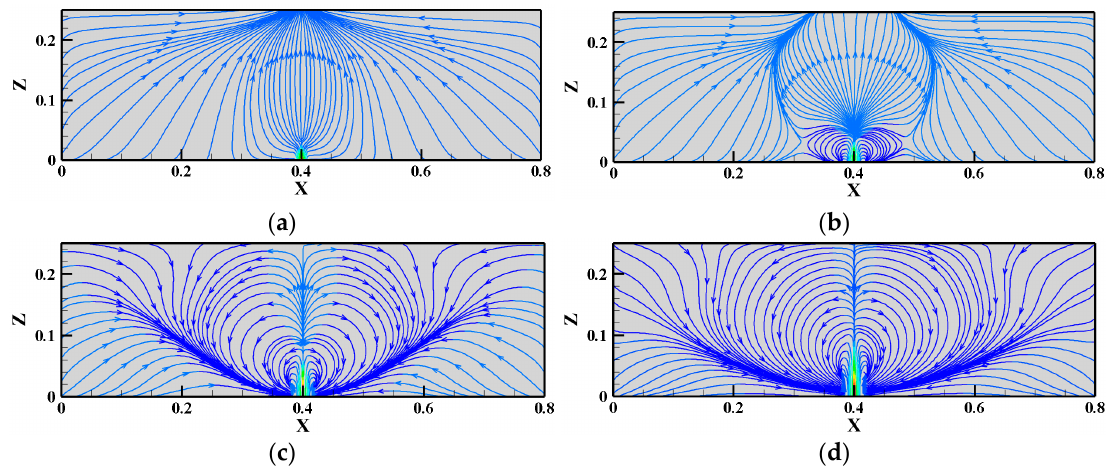
Figure 10. Vortex of the square jet at cross-section Y = 0: ( a ) case 5, ( b ) case 6, ( c ) case 7, ( d ) case 8.